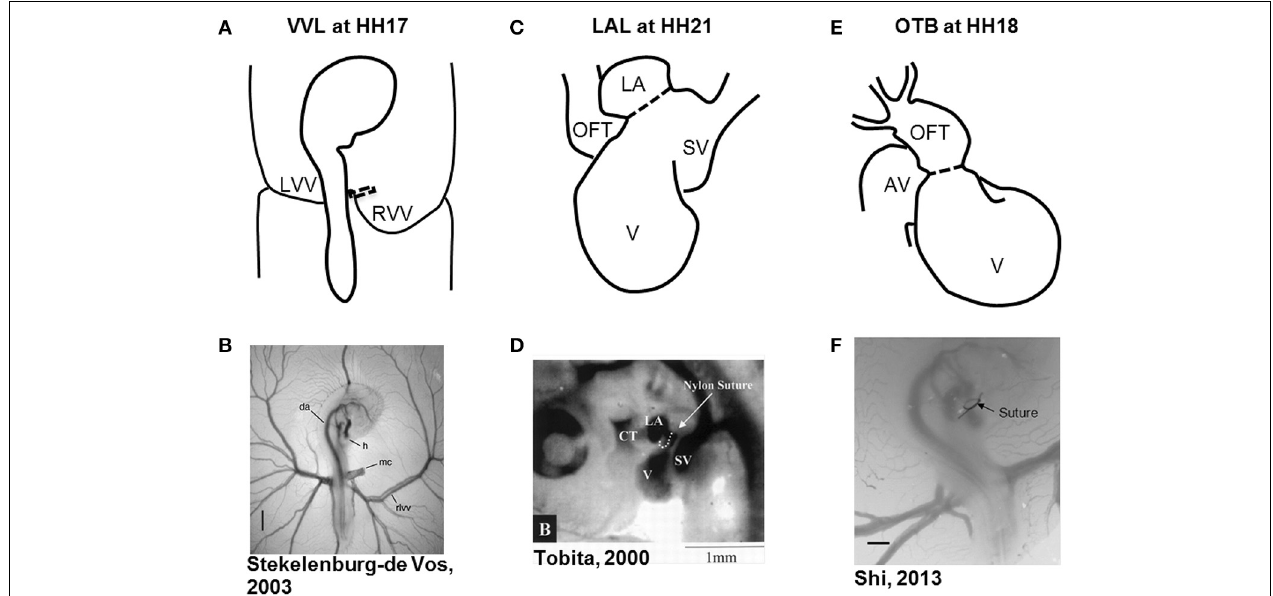
FIGURE 1 | Schematic and experimental photos of the three surgical interventions. (A,B) right VVL at HH17. The dotted line represents the point of manipulation where either a clip or suture obstructs the flow of blood back to the heart. (C,D) LAL at HH21. The dotted line shows where the suture is tied around the left atrium to reduce its size and restrict flow. (E,F) OTB at HH18. The dotted line represents where the suture is tied around the OFT to